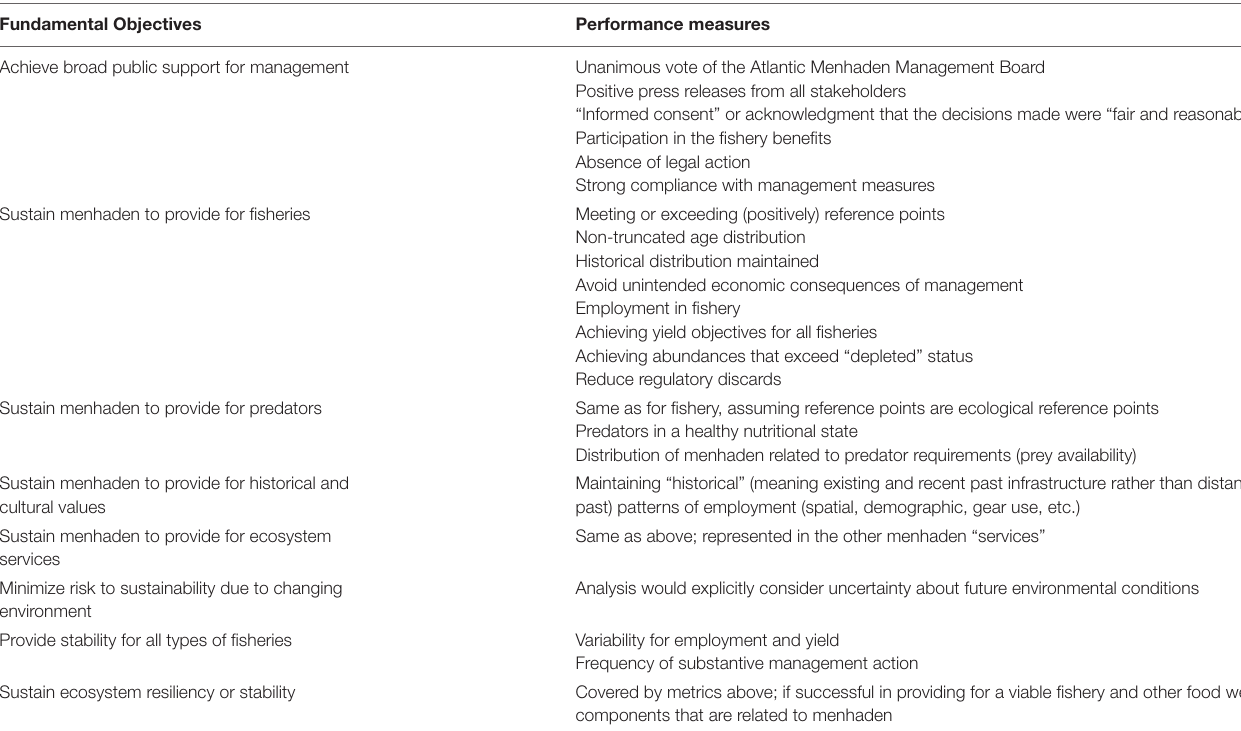
TABLE 2 | Fundamental objectives for ecosystem management of Atlantic menhaden and their associated performance metrics, as identified by Atlantic States Marine Fisheries Commission [ASMFC], 2015. Fundamental Objectives